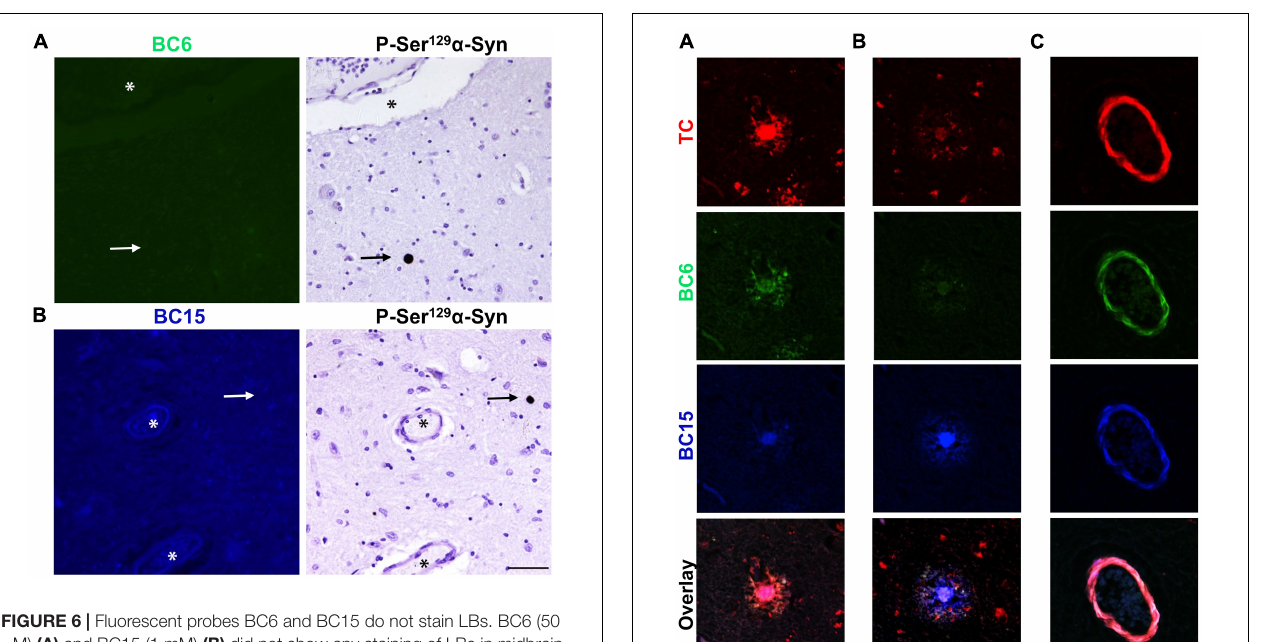
FIGURE 6 | Fluorescent probes BC6 and BC15 do not stain LBs. BC6 (50 µ M) (A) and BC15 (1 mM) (B) did not show any staining of LBs in midbrain sections from a patient affected by LBD. Mirror image sections show P-Ser 129 α -syn immunohistochemical staining of α -syn aggregates in the form of LBs (arrows) to confirm the presence of pathology. The images of the dyes-staining were flipped horizontally to match the same location of the immunohistochemically-probed sections. The asterisks in both sections correspond to the same structures. Scale bar 50 µ m.